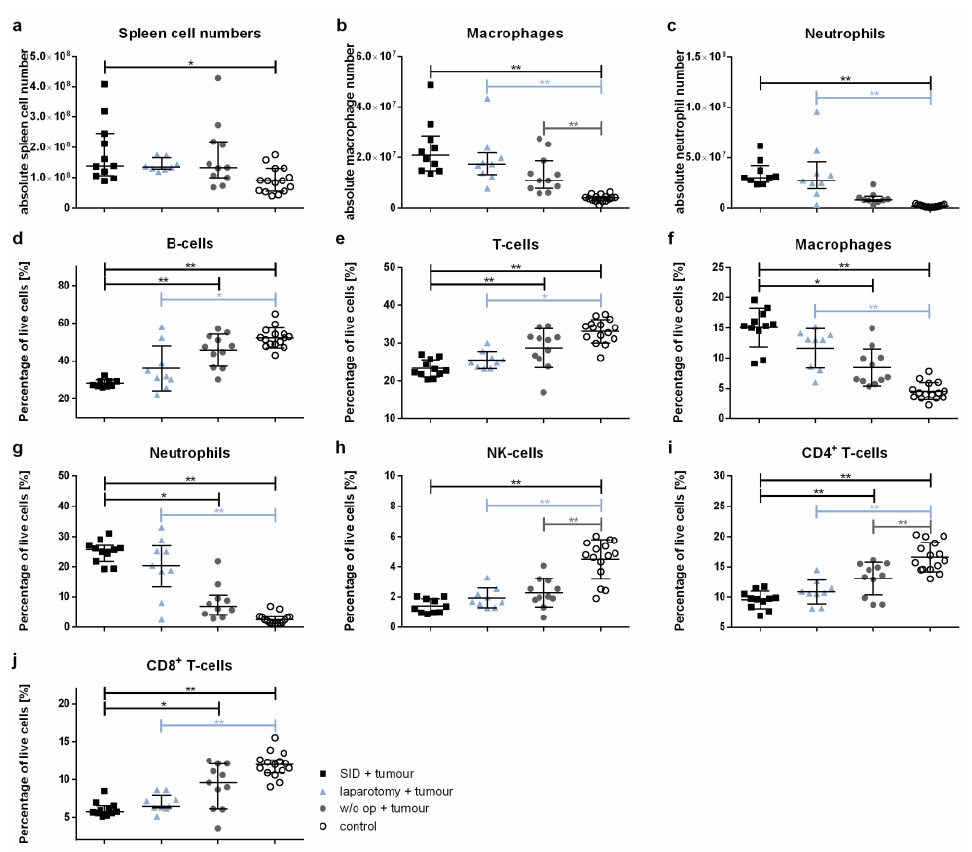
(Figure 7f,g). The differences in B-cell, T-cell, neutrophil, and macrophage numbers were also present in the comparison of tumour-free control animals and tumour- free animals subjected to laparotomy and SID (Figure A1d–g). NK-cell relative cell numbers were decreased in the spleen of all tumour-bearing animals compared to the tumour-free control animals (Figure 7h).